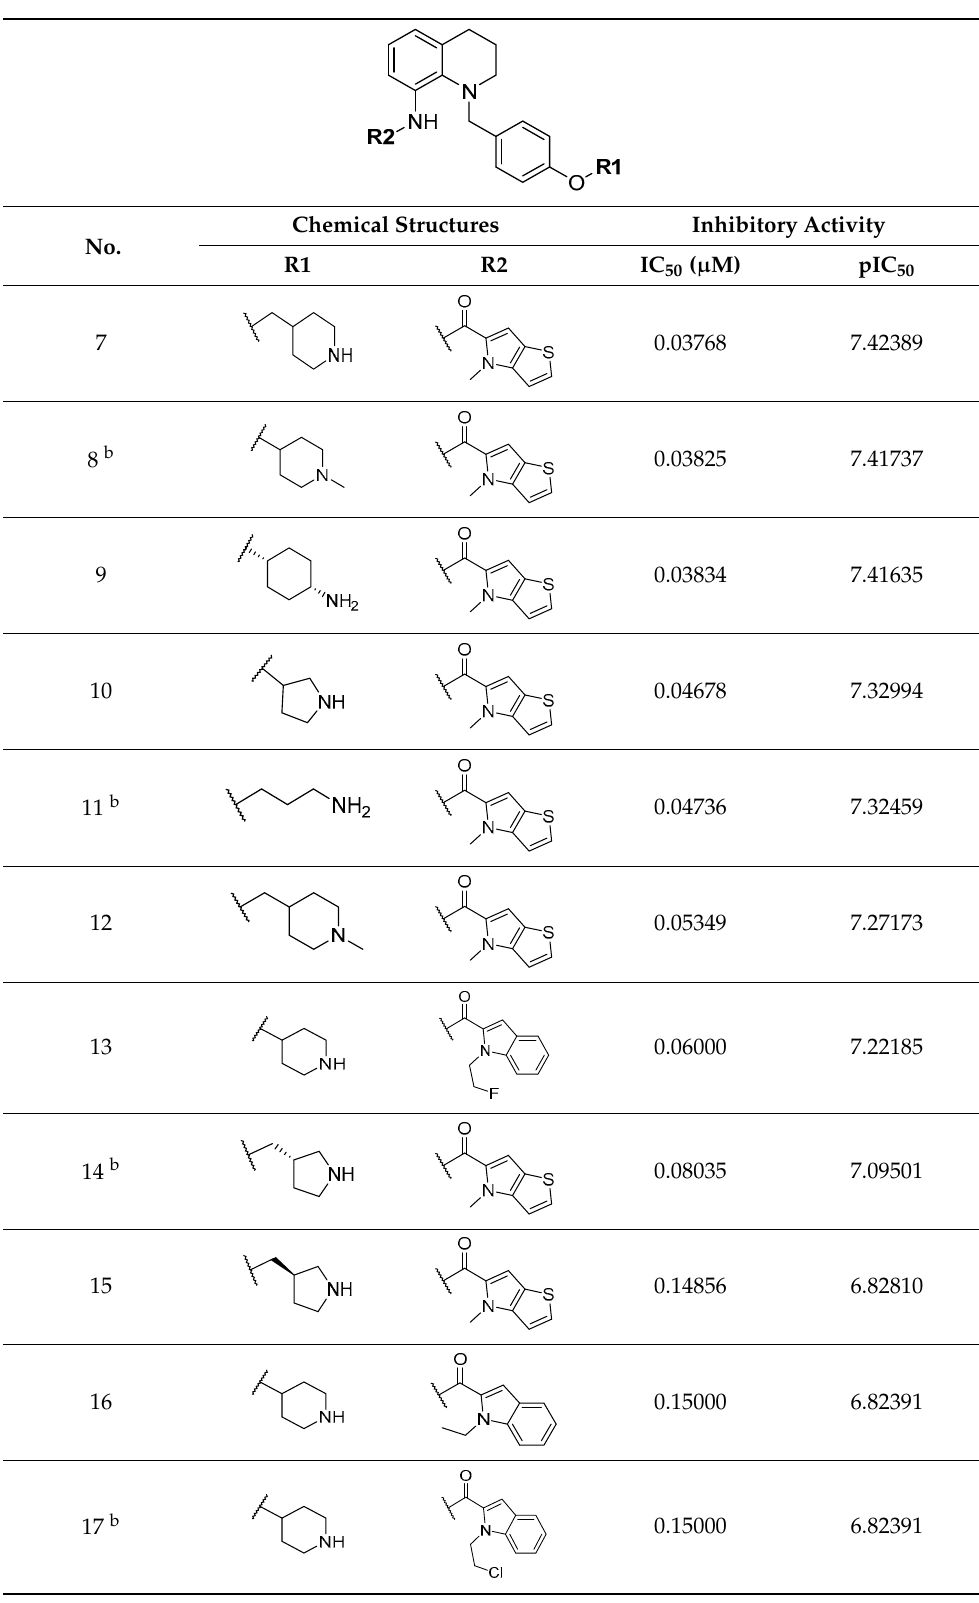
Table 8. Structures and inhibitory activity of tetrahydroquinoline derivatives.